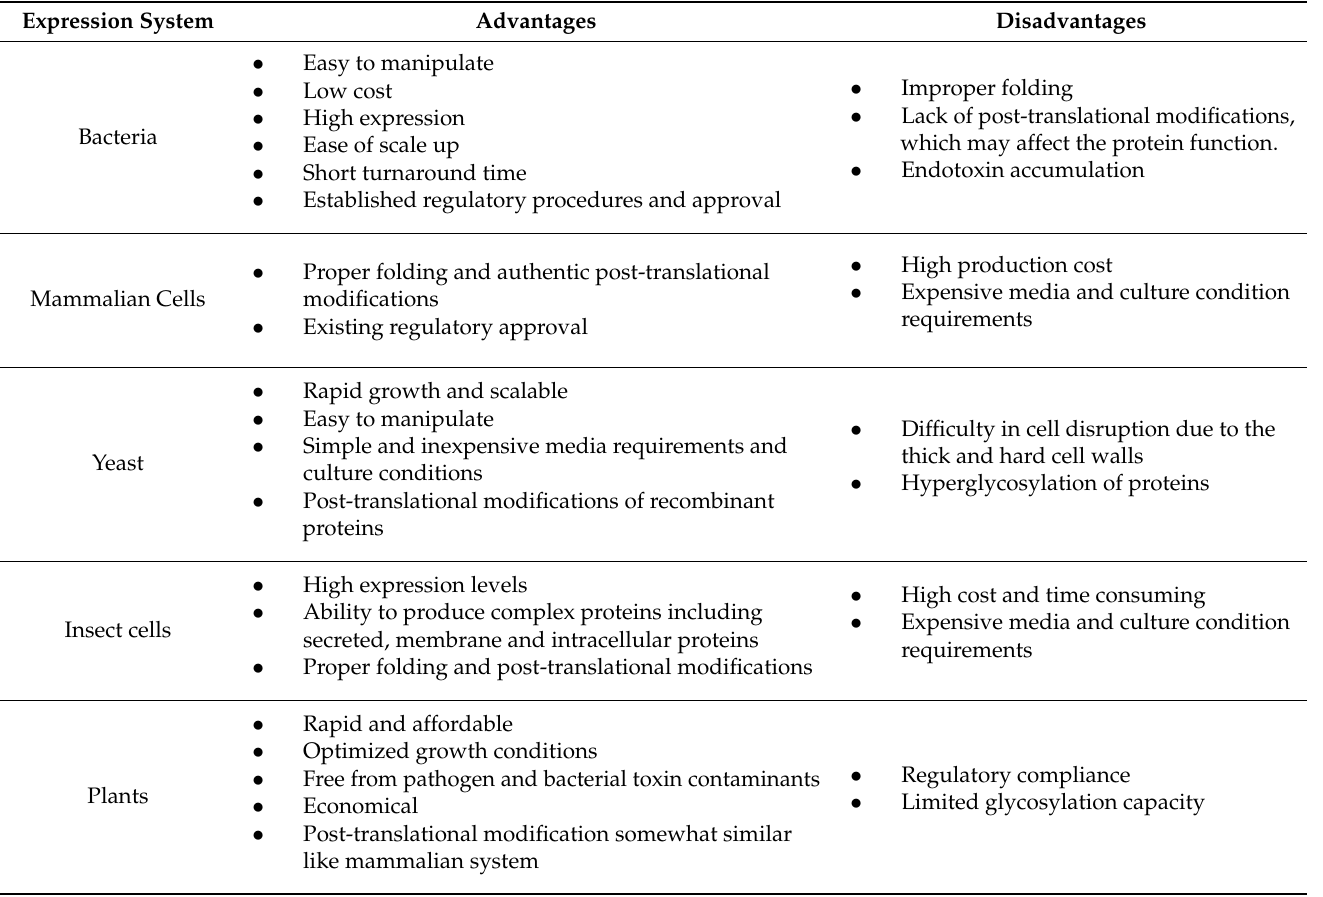
Table 2. Advantages and disadvantages of different host systems available for the production of heterologous proteins for pharmaceutical applications (adapted from Shanmugaraj et al.